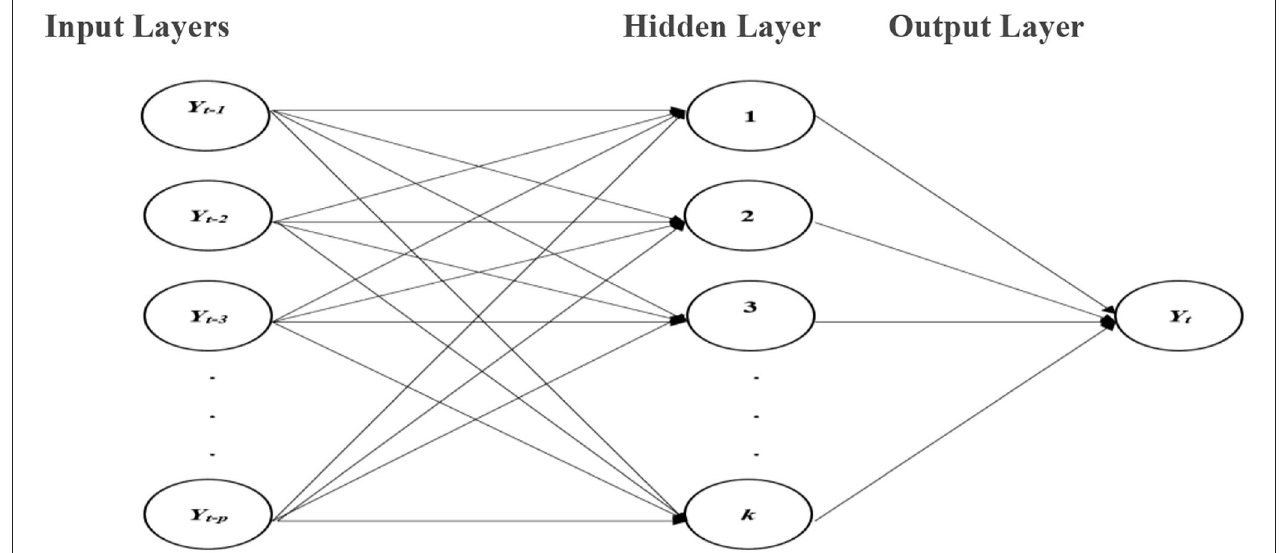
FIGURE 1 | NNAR model with p autoregressive terms as inputs and one hidden layer with k nodes.